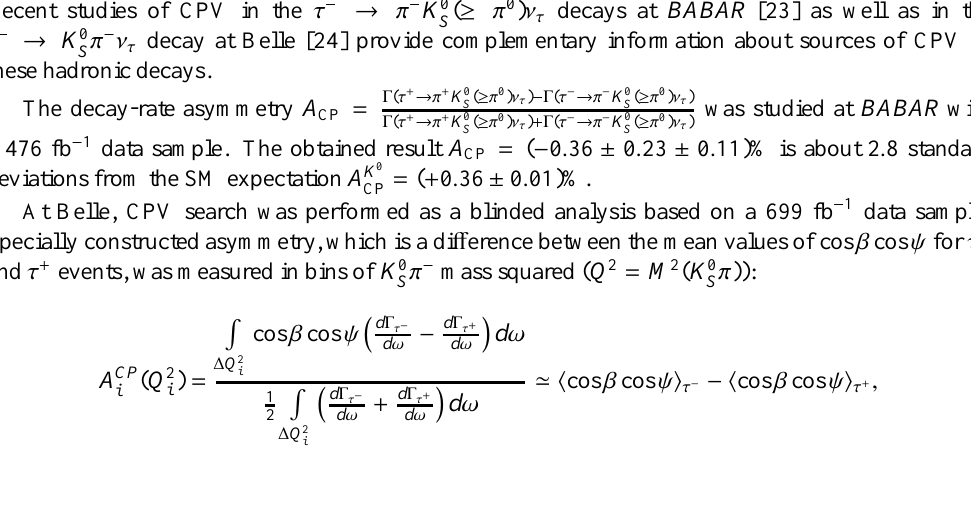
The branching fraction is calculated as B l = N sel (1 − f bg ) / (2 σ ττ L ǫ MC ), where σ ττ = (0 . 919 ± 0 . 003) nb is the cross section of the τ -pair production [20], L = 431 fb − 1 is the total integrated luminosity, and ǫ MC is detection e ffi ciency determined from the MC simulation. The e ffi ciencies are ǫ MC = (0 . 105 ± 0 . 003)% and ǫ MC = (0 . 480 ± 0 . 010)% for the τ → e ν ¯ νγ and τ → µν ¯ νγ